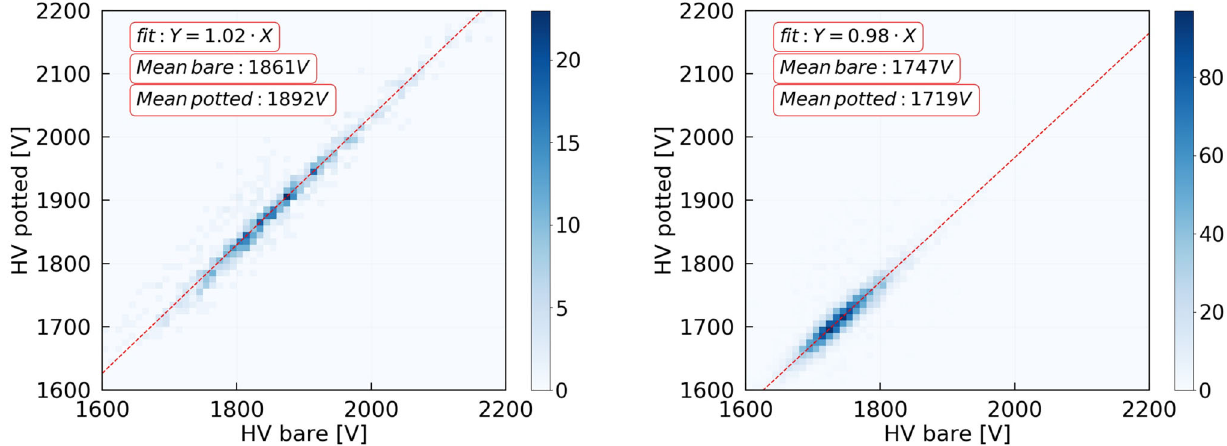
Fig. 45 Working HV of potted PMTs for a gain of 1 × 10 7 . Left: HV of bare vs. potted HPK PMTs; right: HV of bare vs. potted NNVT PMTs